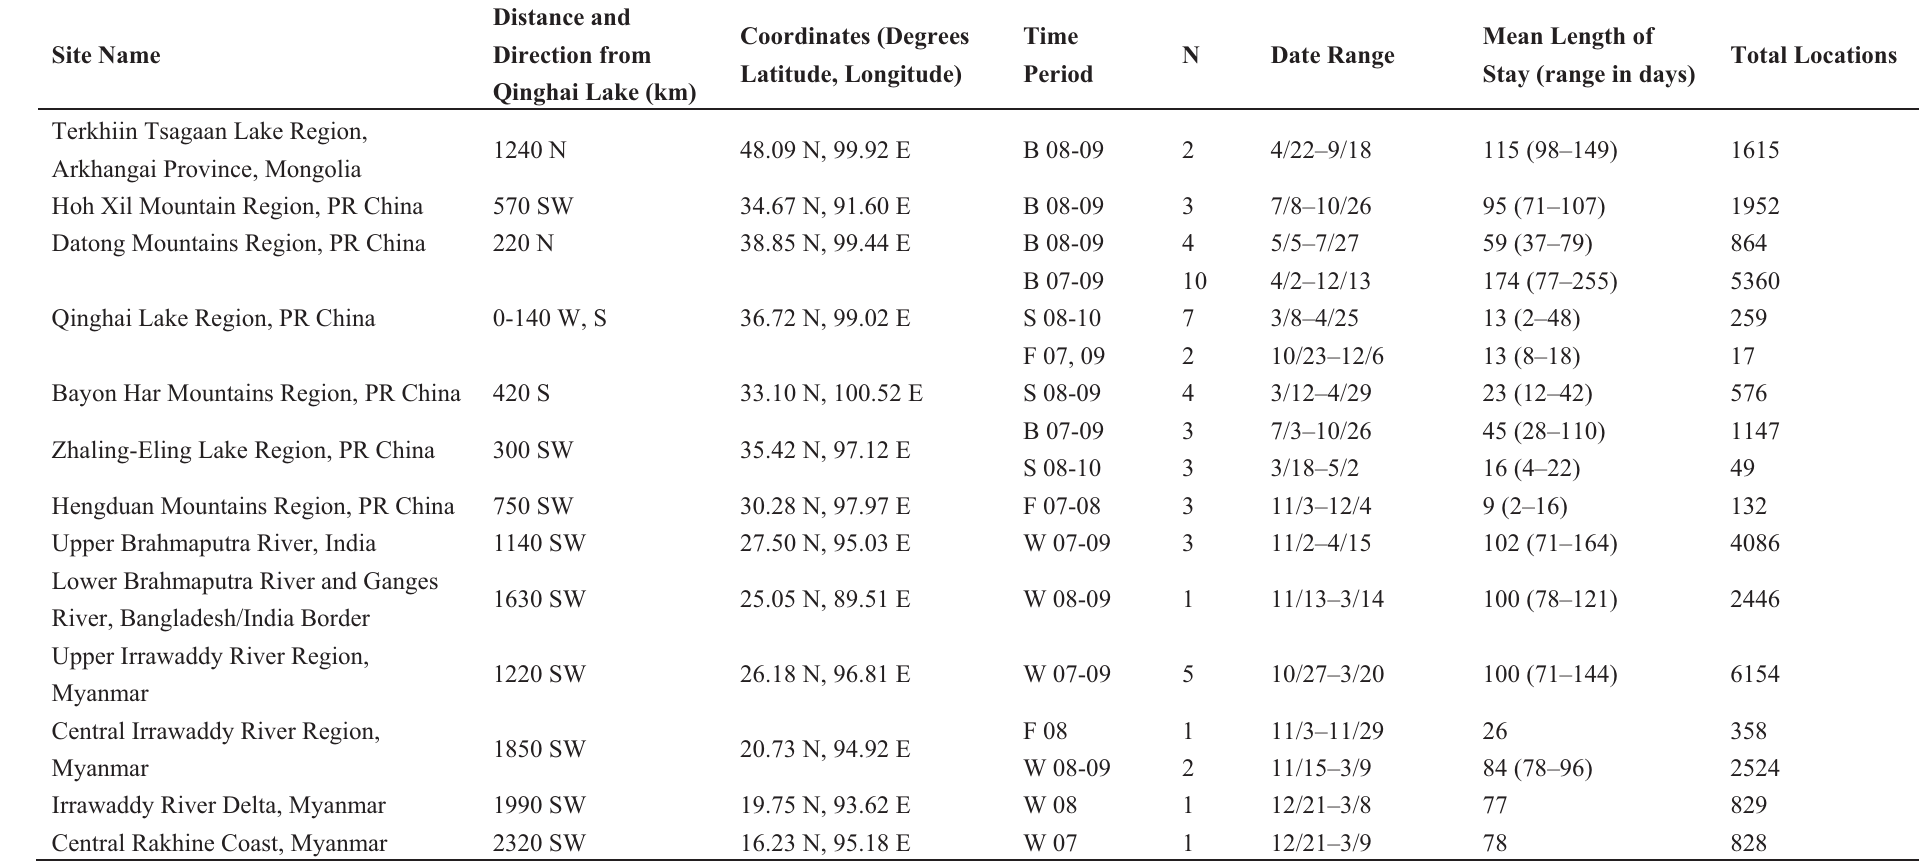
Table 2. Migration stopover sites and wintering and breeding grounds of ruddy shelducks marked with satellite transmitters at Qinghai Lake, Qinghai Province, China from 2007 – 2008. Date ranges indicate arrival to departure, and sample sizes are number of unique individuals found at a site during a given time period. Primary breeding grounds (B), spring (S) and fall (F) migration stopover, and wintering grounds